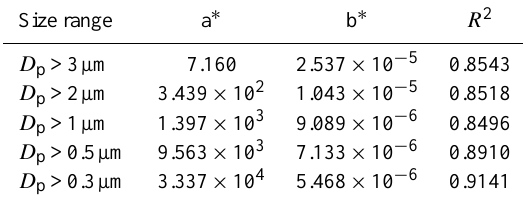
Table 1. Fitting parameters in the exponential decay for aerosol number concentrations of each size from 09:45UT on 14 August (DOY = 226.407) until 06:25UT on 16 August (DOY =